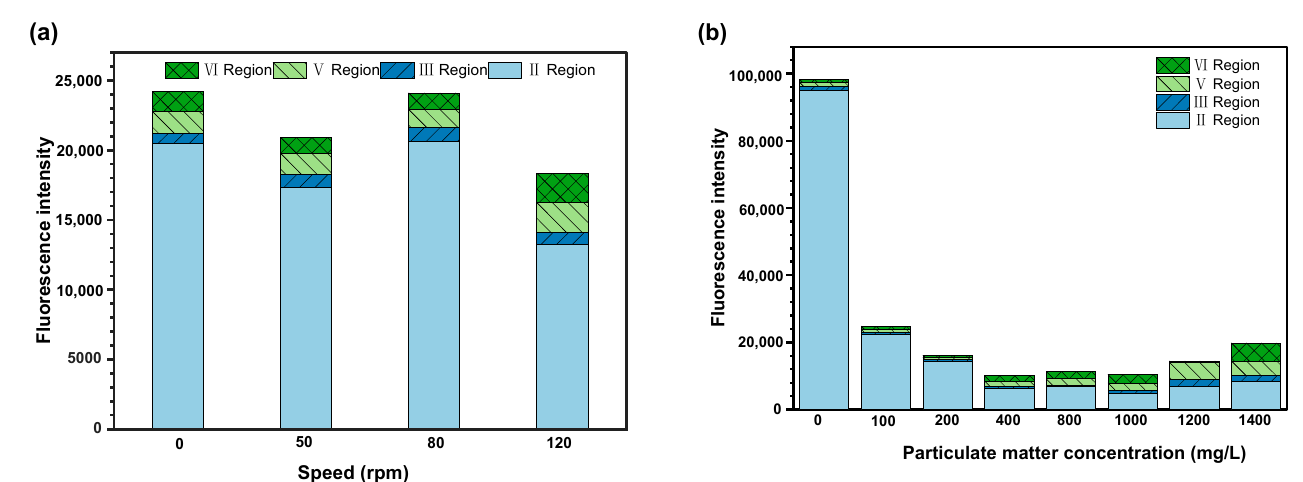
Figure 5. Effect of particulate matter concentration ( a ) and hydraulic conditions ( b ) on EPS fluorescence intensity.